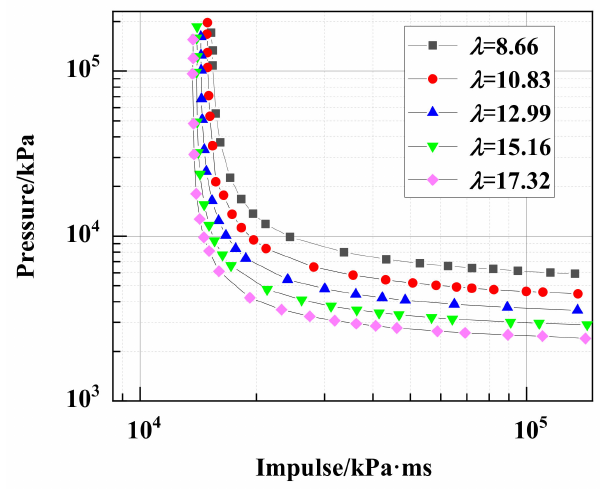
Figure 12. P-I curves of bending response with different slenderness ratios.